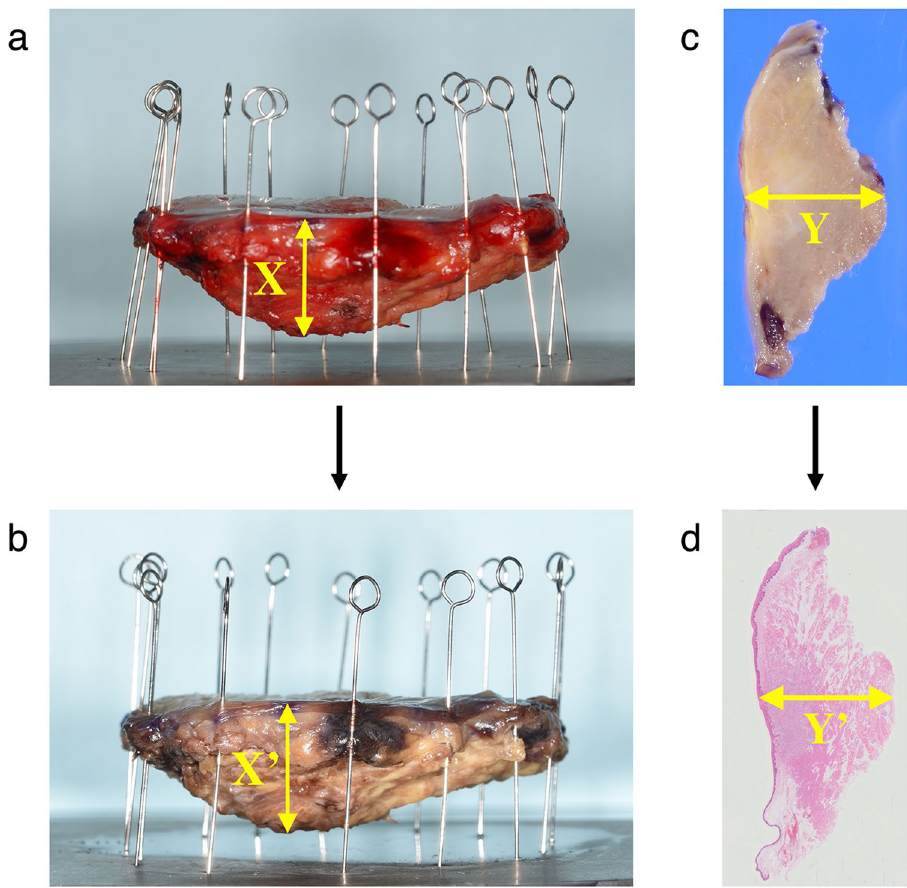
Figure 3. ( a ) Before formalin fixation and ( b ) after formalin fixation. The shrinkage rate at the maximum width by formalin fixation (a → b). The maximum width was measured (X [mm]) before formalin fixation. After fixation, the width was measured at the same site as X and determined as X ′ (mm). ( c ) Sliced specimen and ( d